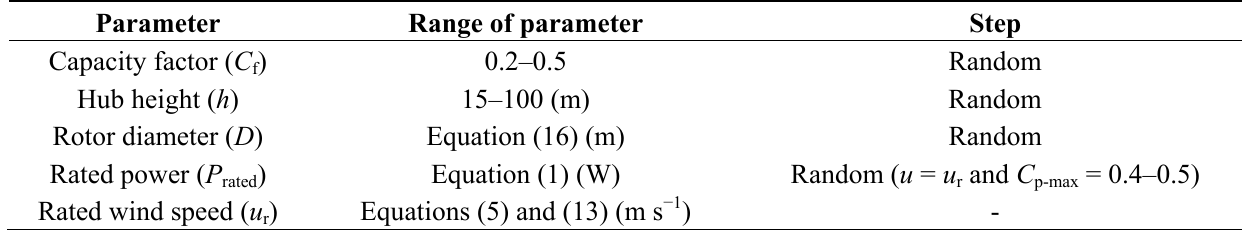
Table 3. Variation range of optimization